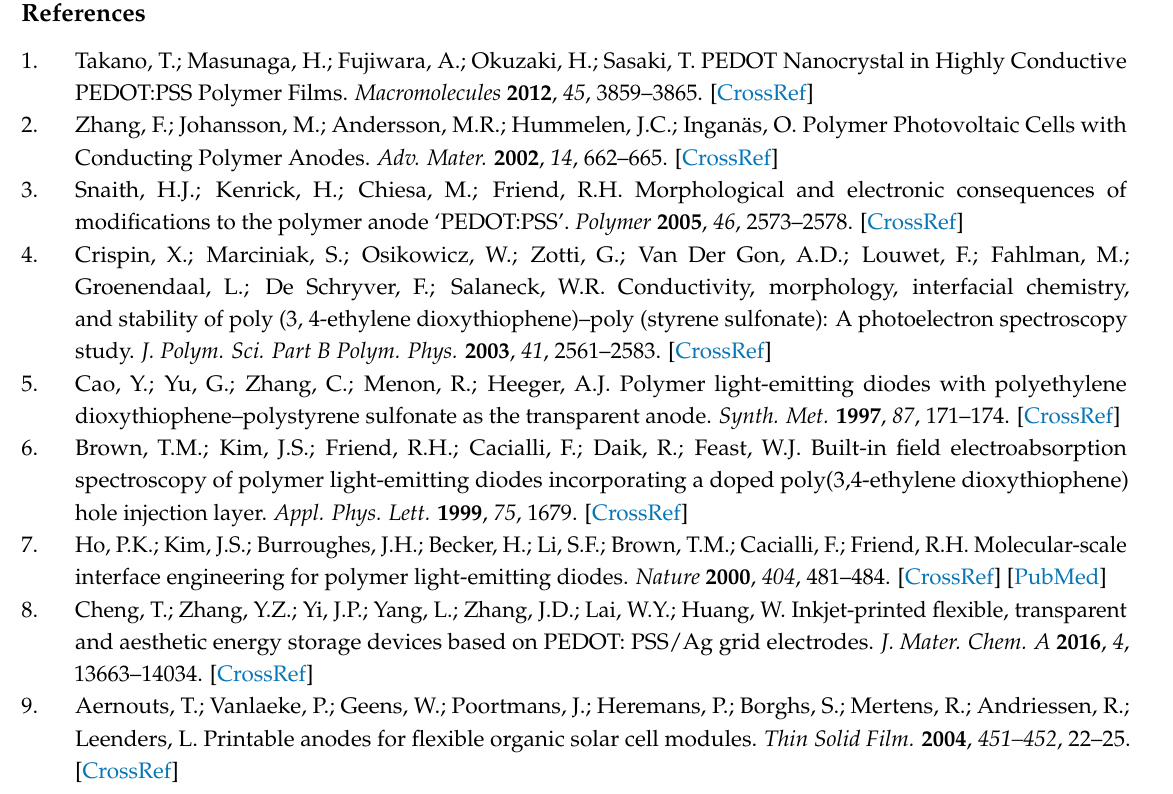
Figure S1: Chemical structure of PEDOT:PSS [19], Figure S2: Charge-discharge characteristics of blank devices (without PEDOT:PSS) using various electrodes (SS/SS, Ag-PBO/Ag-PBO, SS(+)/Ag-PBO( − ), and SS( − )/Ag-PBO(+)), each charged at 3